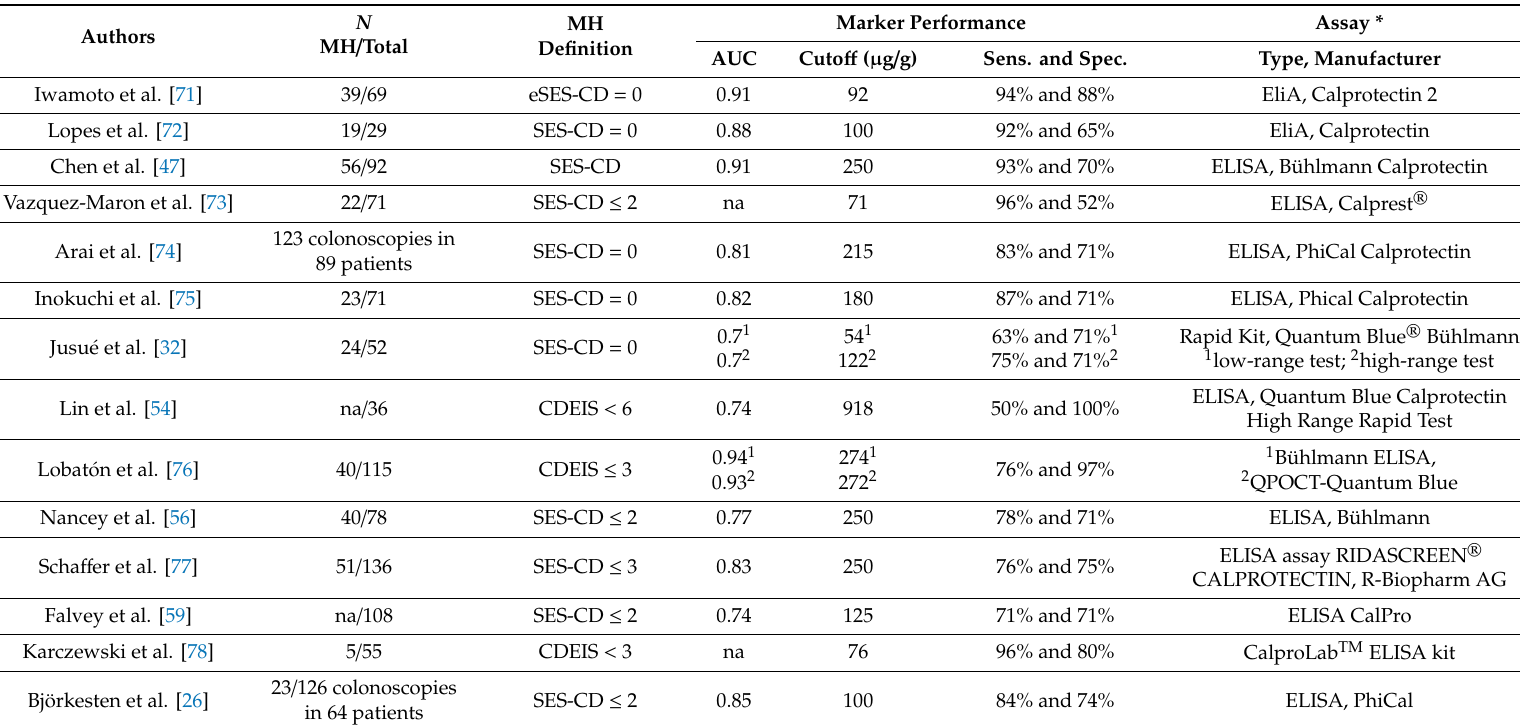
Table 3. Diagnostic performance of fecal calprotectin in MH detection for Crohn’s